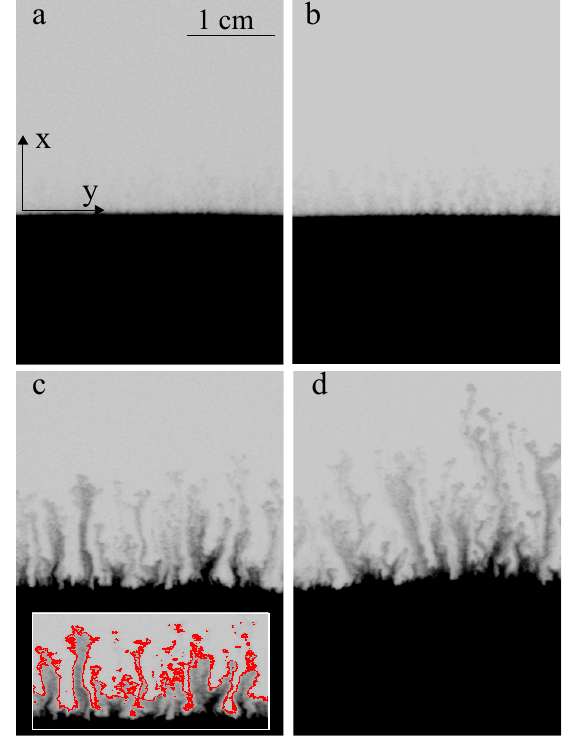
Figure 2. Normalized concentration C’(x,y) maps for ϕ = 1% (a), 2% (b), 3% (c) and 5% (d) at t = 2700 s. Fingering is observed in all cases, but much stronger for ϕ ≥ 3%. The fingers grow faster, and carry more solute across the initial interface, as ϕ increases. Inset in c) depicts the iso- concentration front for C’ = 0.03 for the map shown in c). The iso-concentration fronts are used in the following to estimate a characteristic fingertip